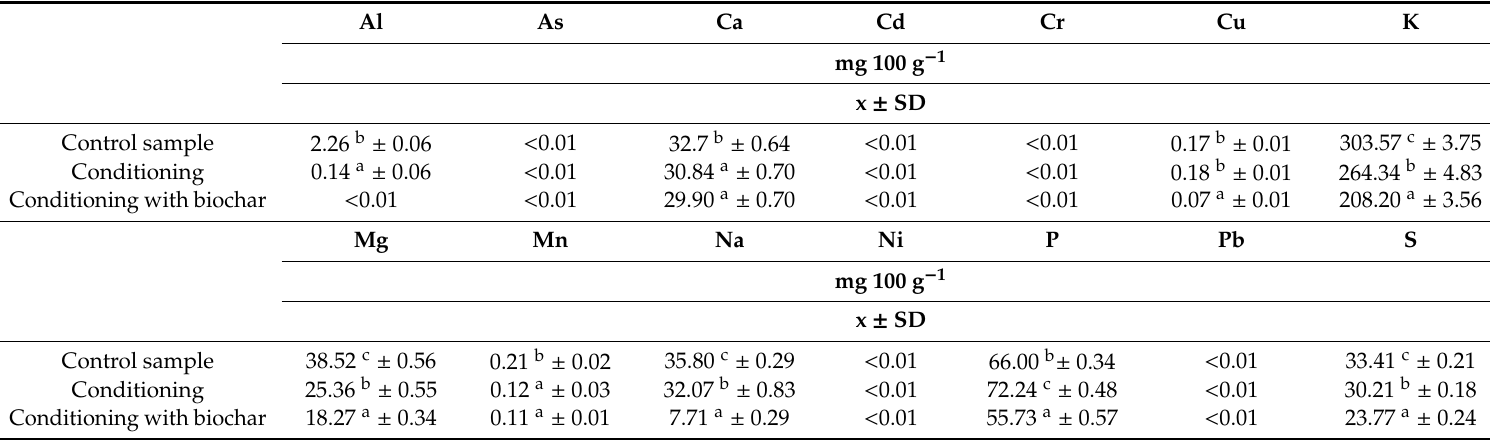
Table 5. Contents of selected macro- and micro-elements in overground parts of Virginia mallow plants in the control sample, in the hydro-conditioned sample, and the sample hydroconditioned with biochar added. X–mean, SD–standard deviation. According to Duncan’s test, means marked with the same letter are not significantly di ff erent at α ≤